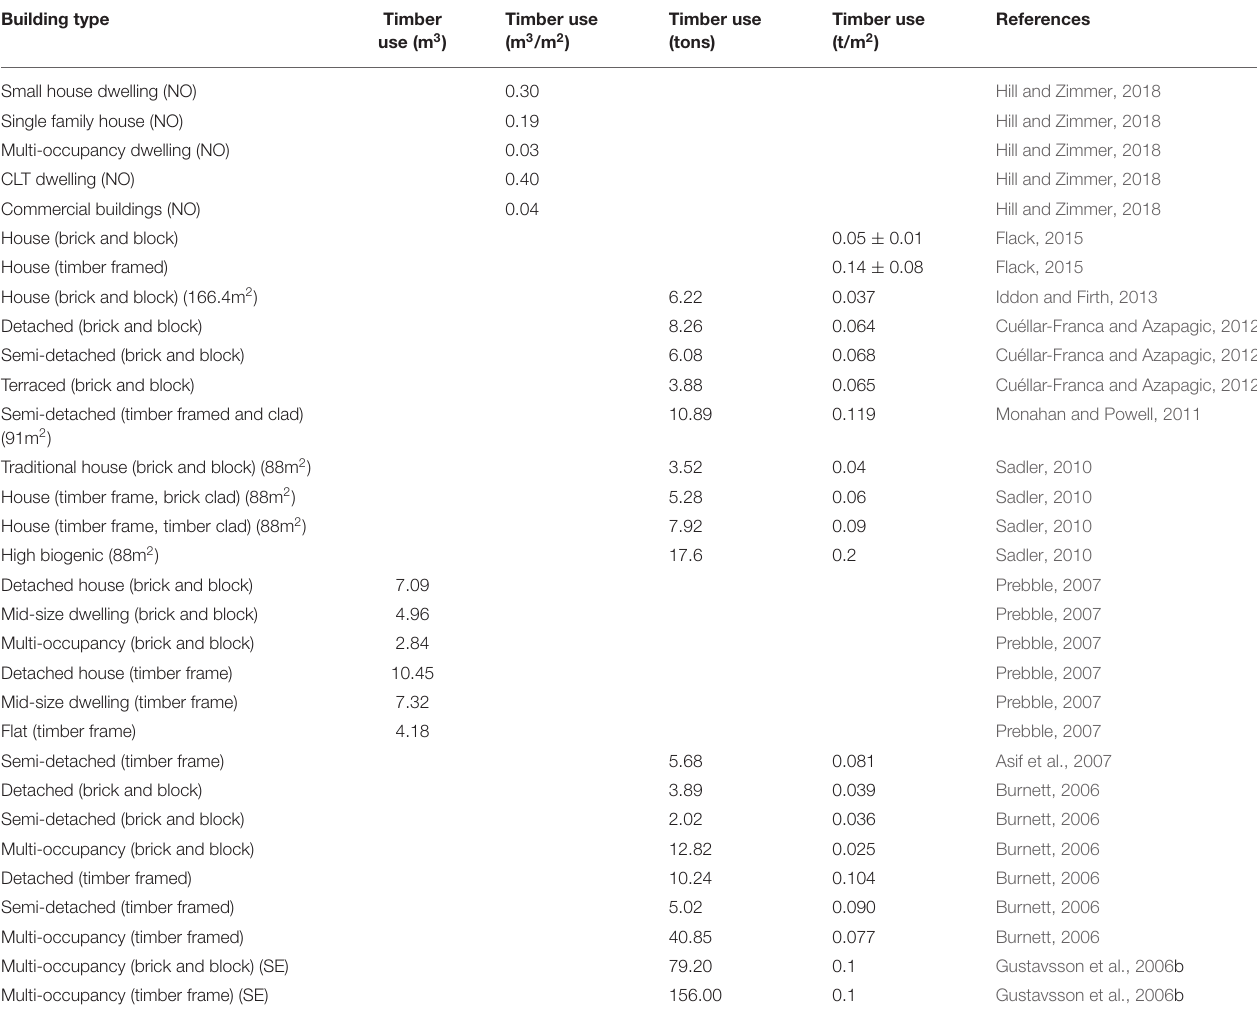
TABLE 1 | Timber use for different building types (UK unless otherwise